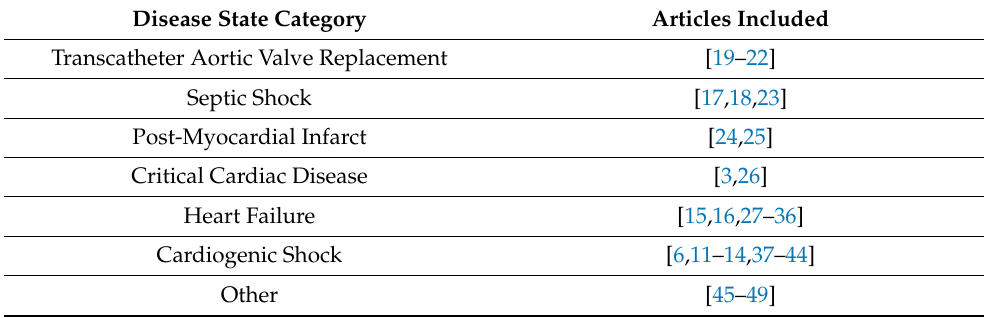
Table 1. Categorical organization of articles in literature review based on disease